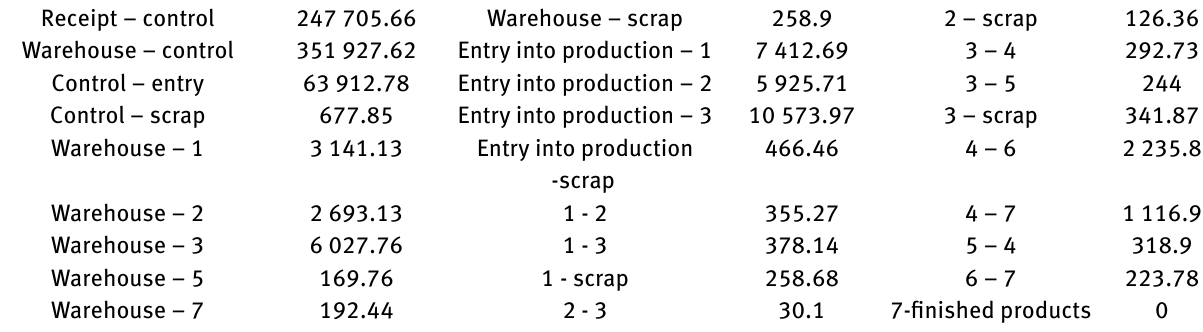
Table 4: The costs of material flows after optimization